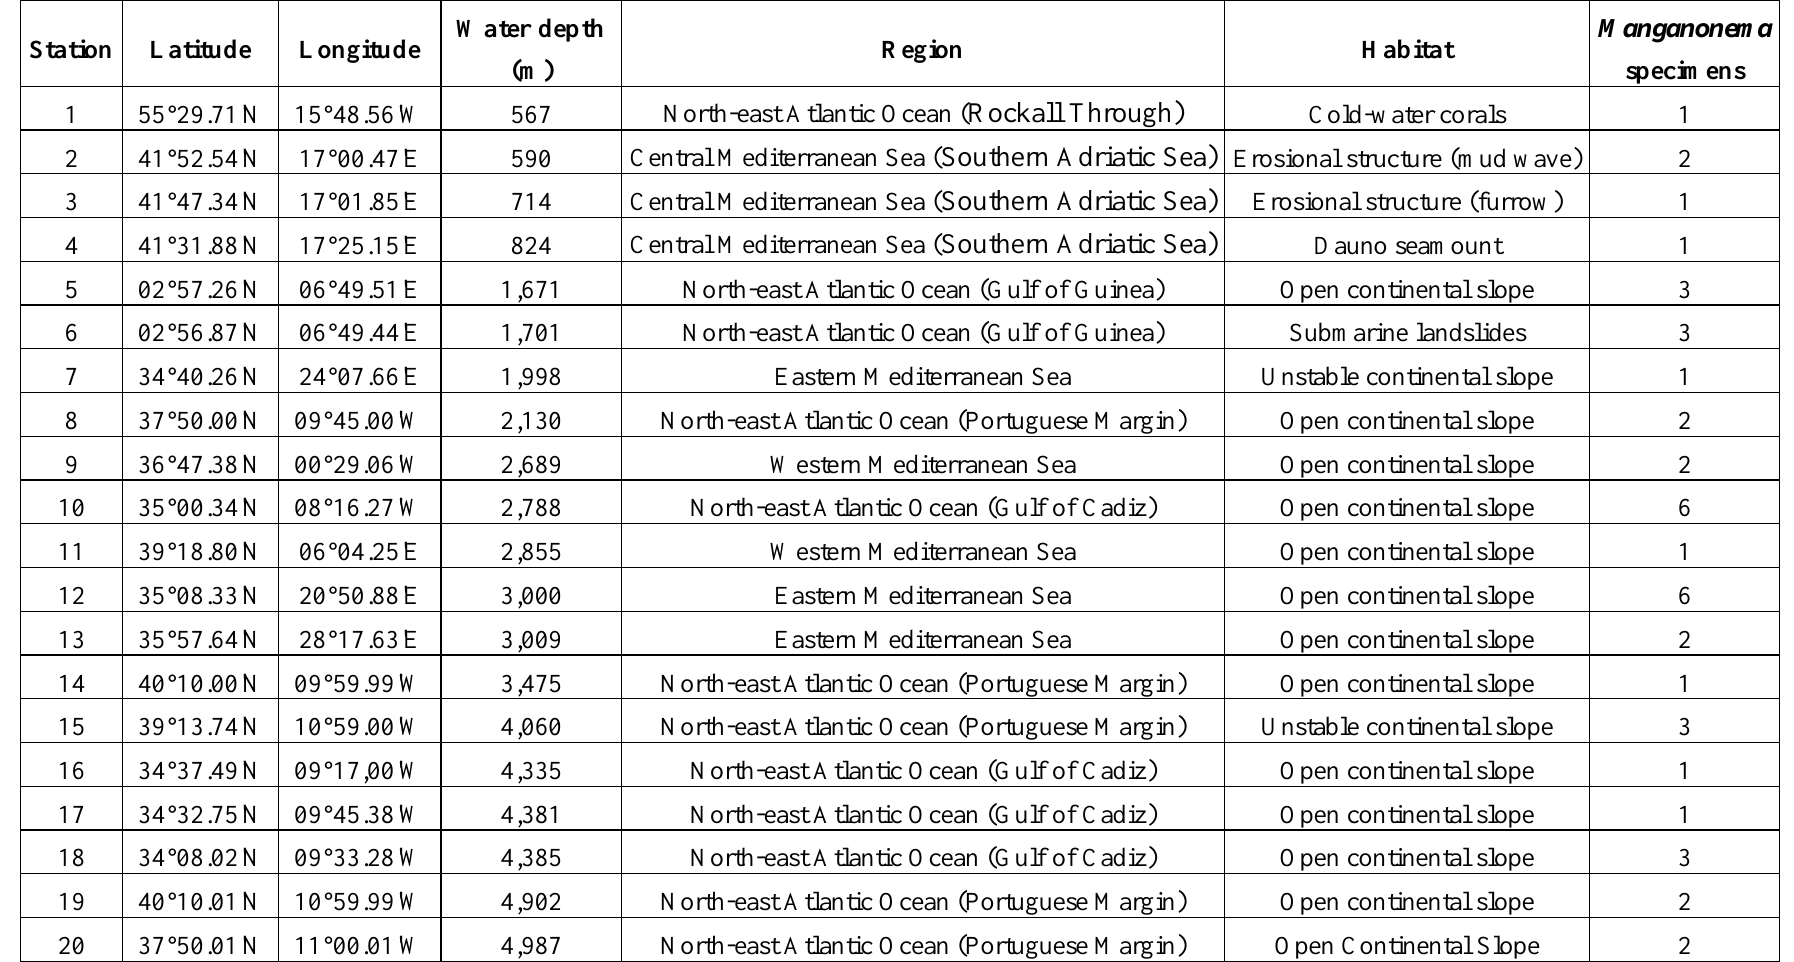
Table 1. List of the sampling sites. Reported are latitude longitude, water depth, region, habitat and number of investigated Manganonema specimens for each